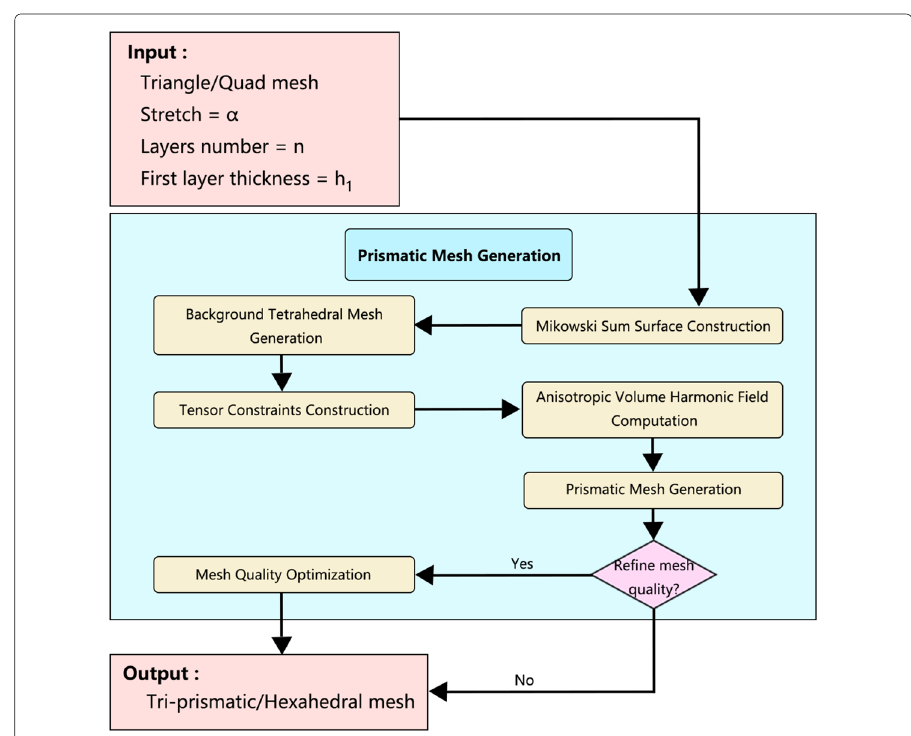
Fig. 1 Prismatic mesh generation framework